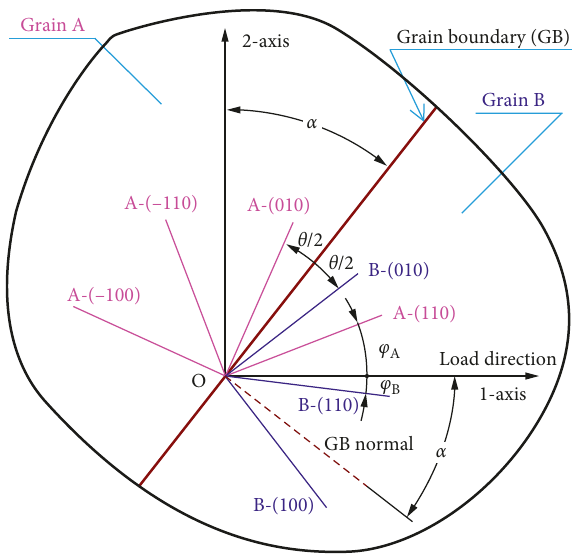
Figure 2: Orientations of two adjacent grains in